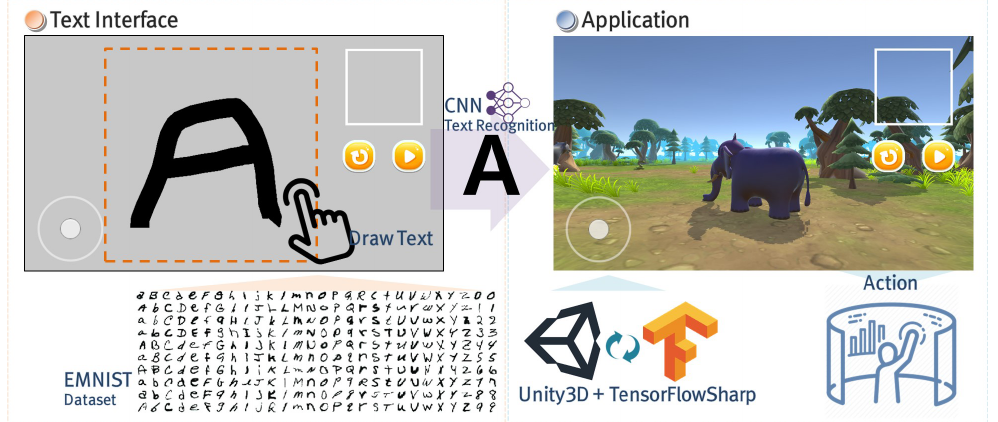
Figure 1. Structure of the proposed text interface using deep